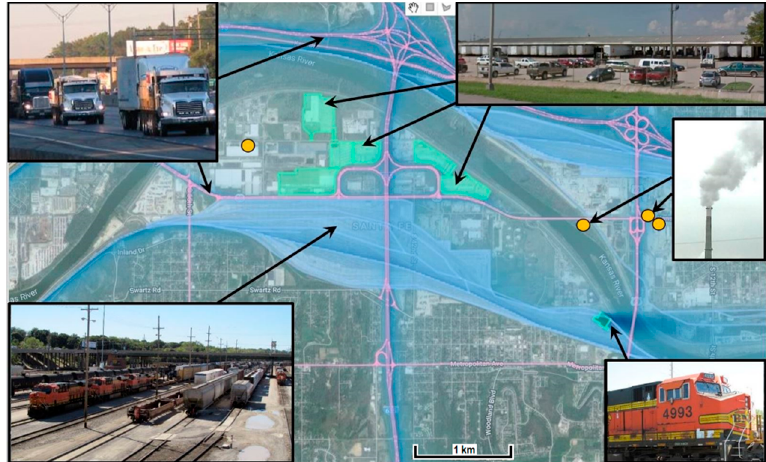
Figure 2. Map of the study area showing locations of emission sources and a screen shot of C-PORT model simulations of primary PM 2.5 concentrations.